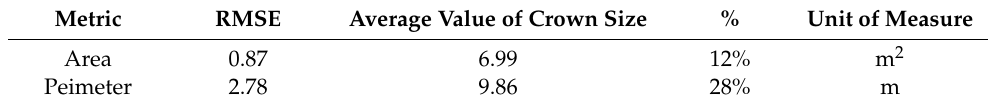
Table 10. Results of the quantitative assessment RMSE for the